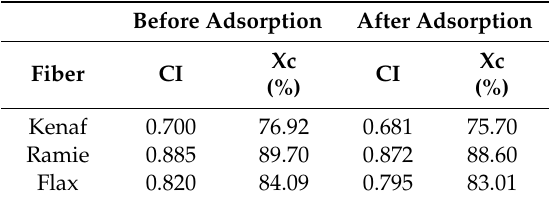
Table 1. XRD data of the adsorbents before and after BY37 removal.